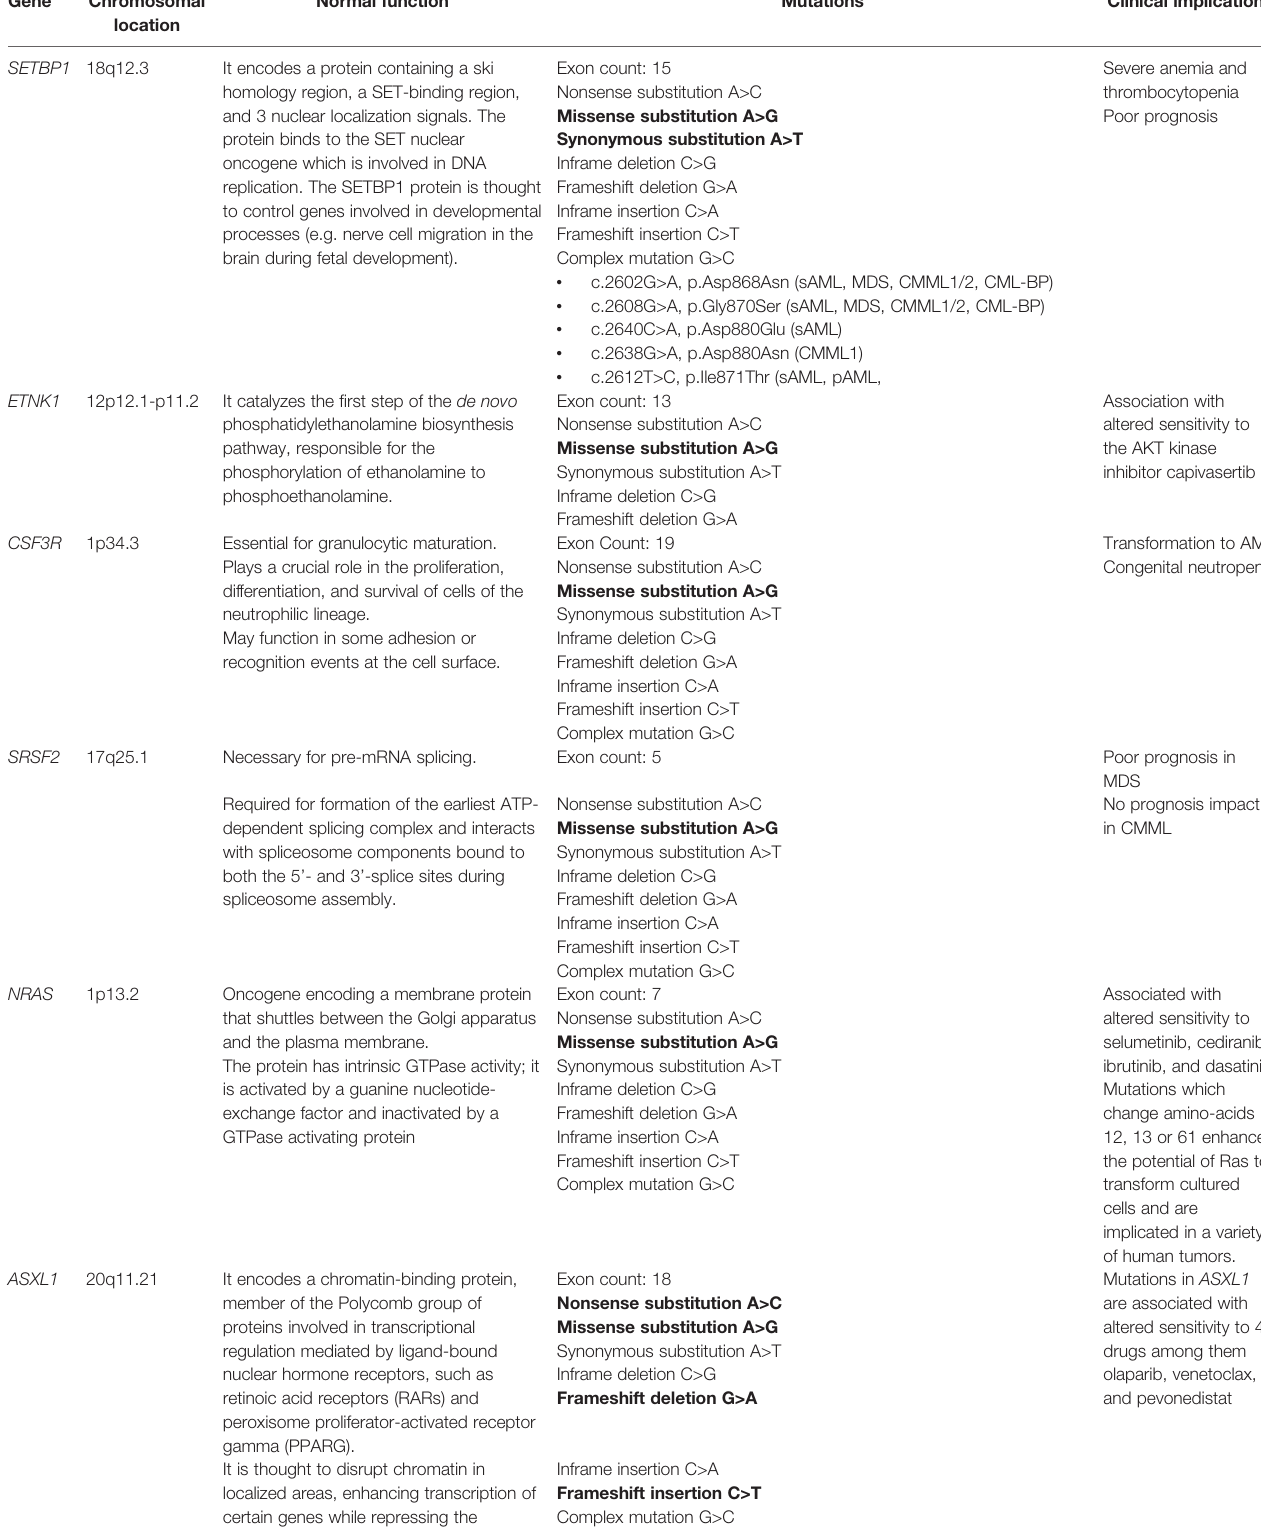
TABLE 2 | Recurrently mutated genes in